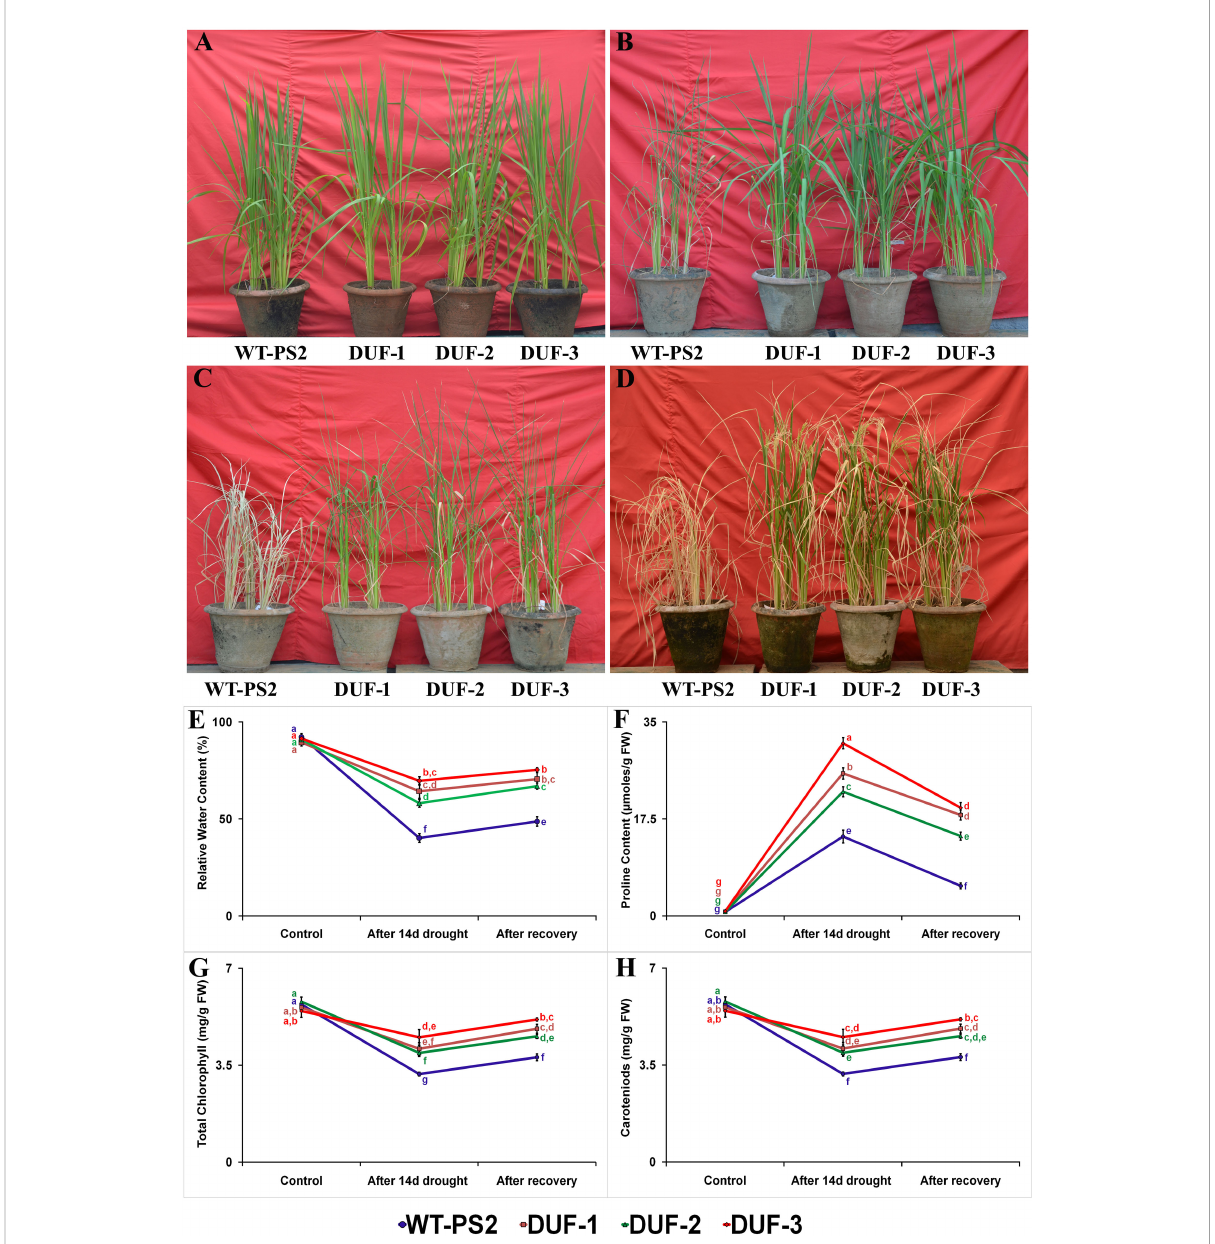
FIGURE 2 Phenotypic and physio-biochemical trait analyses of the AtRd29A::OsSRDP transgenic rice plants and WT in response to water-de fi cit stress. (A) Phenotypic appearance of WT and AtRd29A::OsSRDP transgenic rice plants at the active tillering stage under well water condition, before imposing drought stress, (B, C) WT and AtRd29A::OsSRDP transgenic plants subjected to drought stress for 7 and 14 days, respectively, and (D) recovery of plants after 10 days of re-watering. (E) Relative water content, (F) proline content, (G) total chlorophyll, and (H) carotenoids after 14 days of drought stress. Each value is the average of three independent biological replicates and the vertical bar indicates ± SD. Standard error of means (SD/ √ N; N = 3) are used as error bars, and alphabets above the vertical bars represent statistically signi fi cant differences (Duncan ’ s Multiple Range Test: p ≤ 0.05) between WT and transgenic